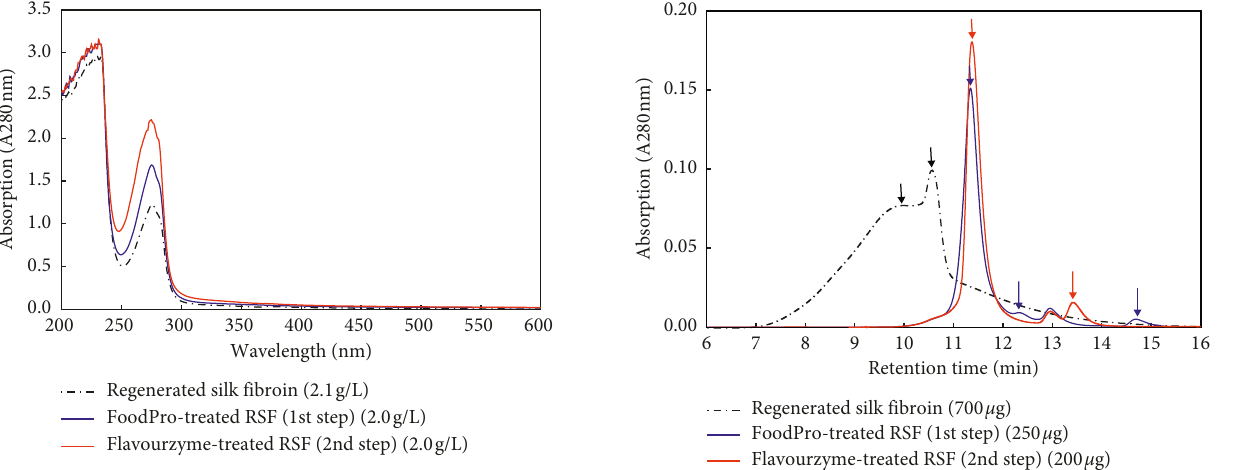
Figure 6: Size-exclusion chromatography of the regenerated silk fibroin and its enzymatic hydrolysates obtained using FoodPro in the 1st step and Flavourzyme in the 2nd